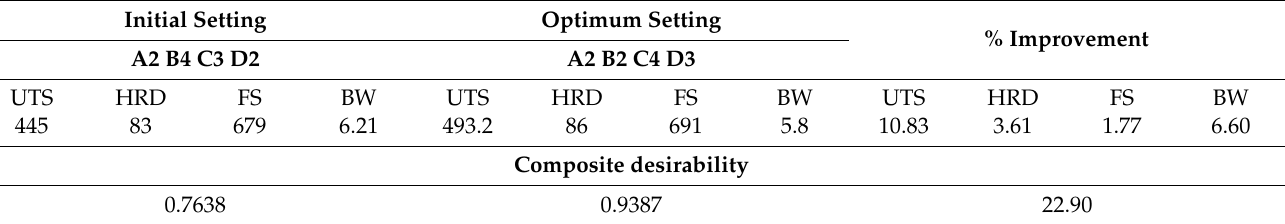
Table 29. Improvement in UTS, FS, HARDNESS, and